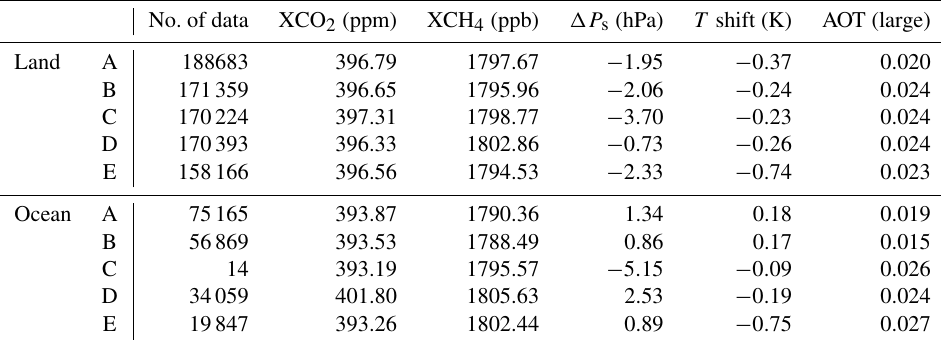
Table A2. Summary of sensitivity test retrieval